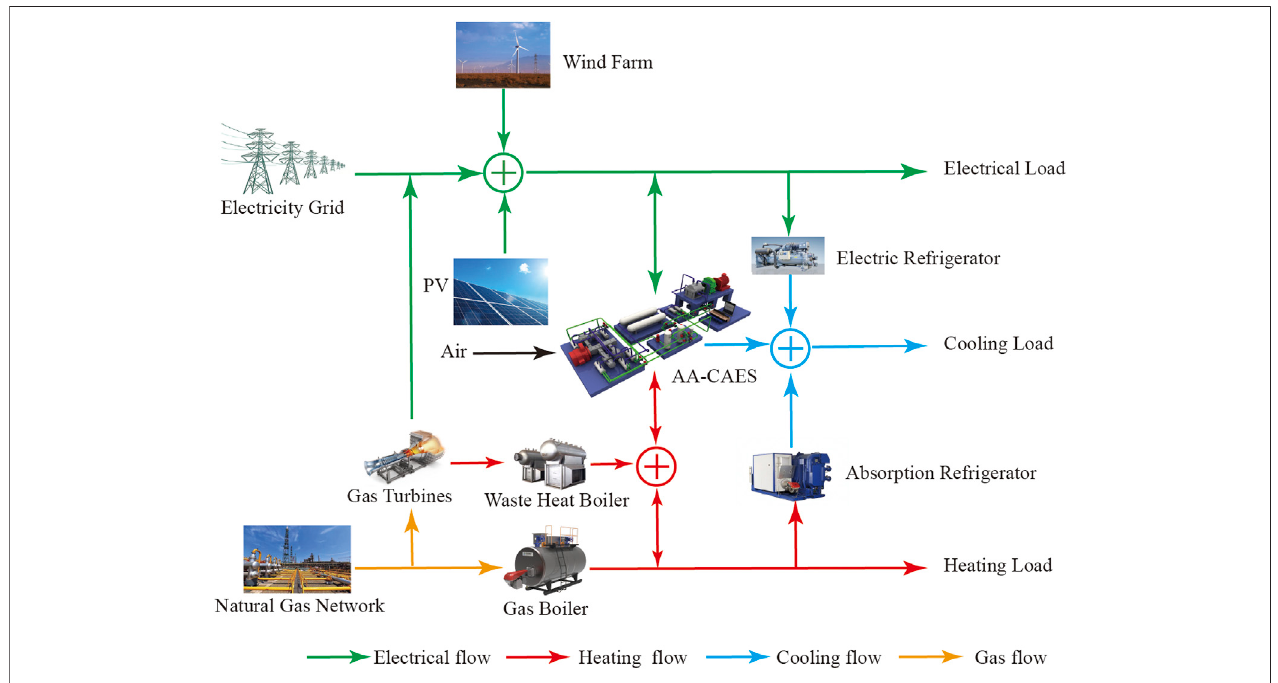
FIGURE 1 | Design framework of the IES with the AA-CAES